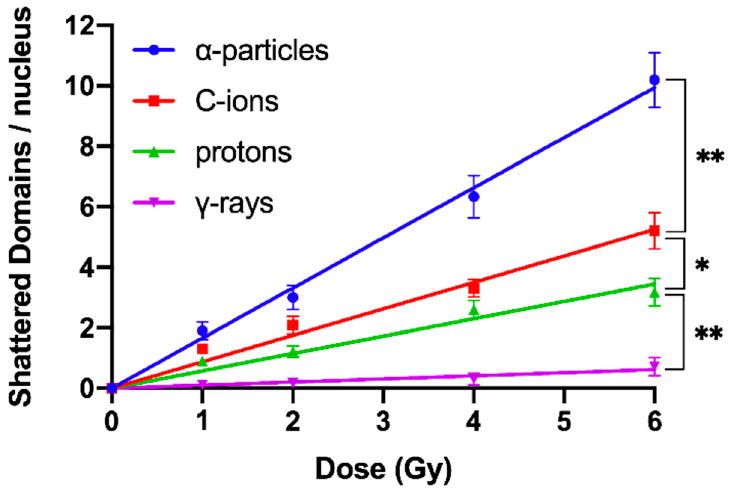
Figure 8. Dose–response curves for the yields of shattered chromosome domains per nucleus, following exposure to various doses up to 6 Gy of the di ff erent radiation qualities. Linear dose–response relationships were obtained with most e ff ective being the α -particles, followed by C-ions, protons, and γ -rays. Based on this cytogenetic endpoint of the initial induction of clustered DNA lesions and formation of shattered chromosome domains, the RBE values obtained were 14.3 for α -particles, 7.5 for C-ions, and 4.9 for protons. (Mean ± SD based on three independent experiments; n ≥ 50 cells analyzed per experimental point; * p ≤ 0.05, ** p ≤ 0.01).